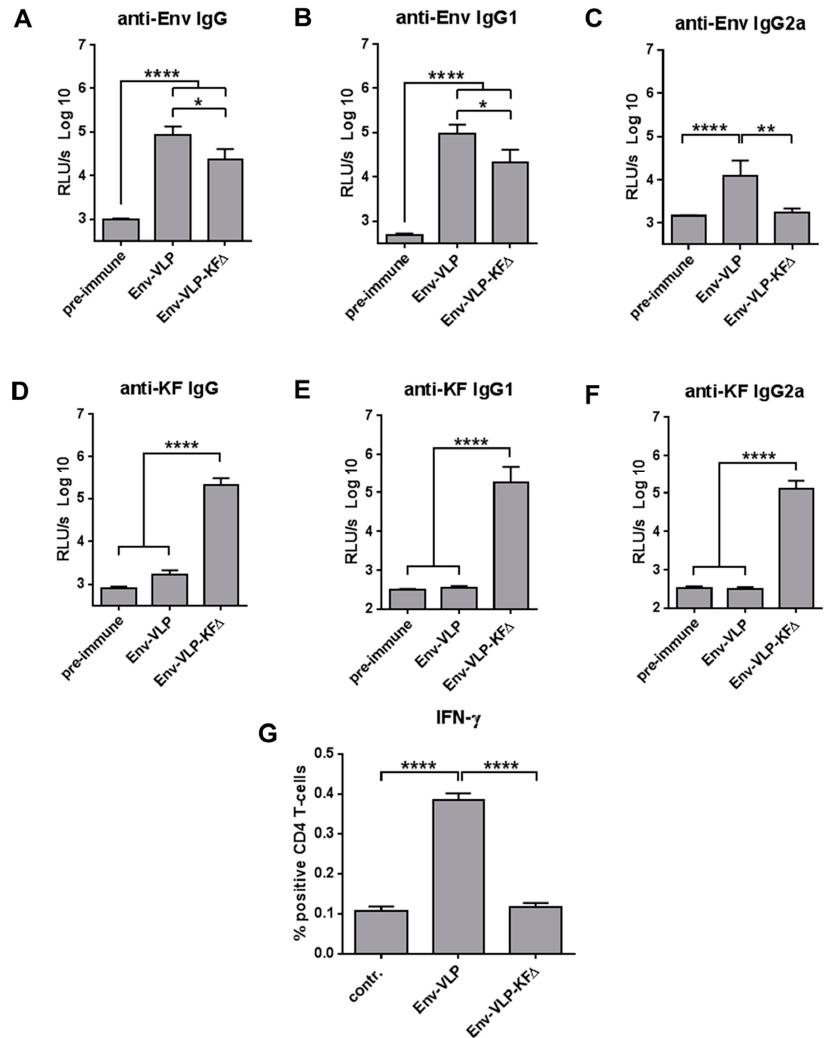
Figure 3. Immunogenicity of Env-VLP nano-vaccines functionalized with KF ∆ . Wt Balb / c mice were immunized i.m. twice (at day 0 and day 35) with either Env-VLP or Env-VLP-KF ∆ containing 400 ng HIV-Env / mouse. The sera samples were obtained at day 0 before immunization (pre-immune sera) and at day 49 (2 weeks after the second immunization). Humoral immune responses against HIV-Env ( A – C ) and KF ( D – F ) were measured in 1:100 diluted sera samples and expressed as log10-transformed relative light units per second (RLU/s log10). Each experimental group included six mice. The pre-immune sera group contains samples of 12 mice correspondingly. The columns represent the mean values ± SEM. ( G ) Characterization of HIV-Env-specific cellular immune responses in the draining lymph nodes was performed at day 49 (2 weeks after the second immunization). Percentage of CD4+ T-cells producing IFN- γ after in vitro stimulation with HIV-Env T helper peptide was measured by intracellular cytokine staining. The columns represent the mean values of six animals ± SEM. * p < 0.05; ** p = 0.0015; **** p < 0.0001; one-way ANOVA with Tukey multiple comparison post-hoc